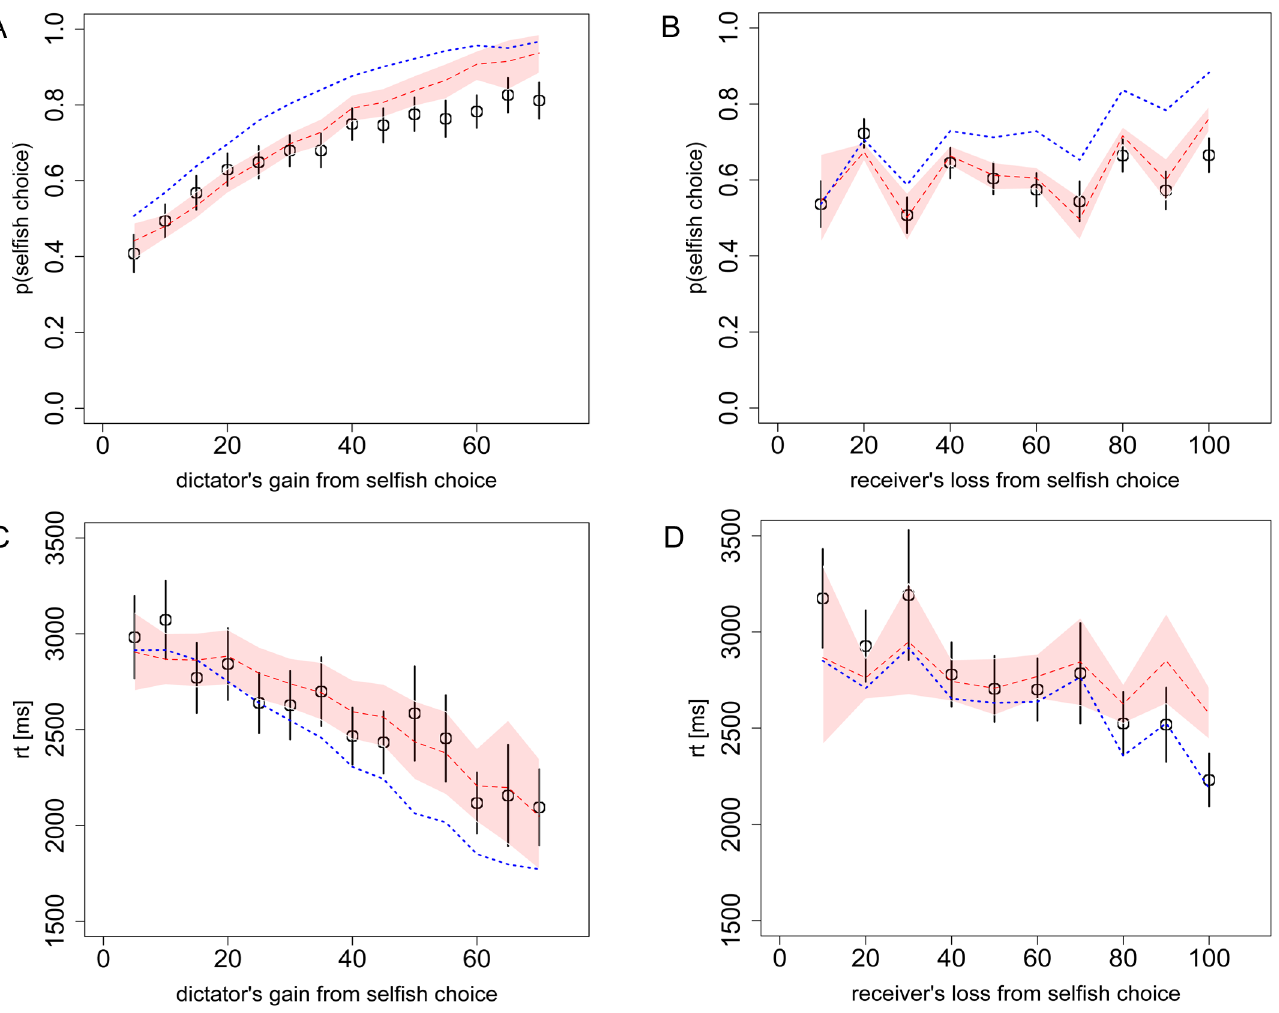
Fig 3. Choices and reaction times from Task 2 (Dictator game). A) The probability of the dictator choosing the selfish option as a function of his own payoff gain from the selfish option, relative to the fairer option, and B) as a function of the receiver ’ s loss from the selfish option. C) The dictator ’ s RT as a function of his own payoff gain from the selfish option, and D) as a function of the receiver ’ s loss from the selfish option. Black circles indicate the aggregate subject data with bars representing s.e.m. Red dashed lines indicate the DDM predictions with 95% confidence intervals. The overlap of these confidence intervals with the data ’ s standard error bars indicates excellent model predictions. Blue dotted lines indicate the alternative DDM with θ = 0.15, which would be the prediction from the widely-used Fehr-Schmidt model of social preferences.